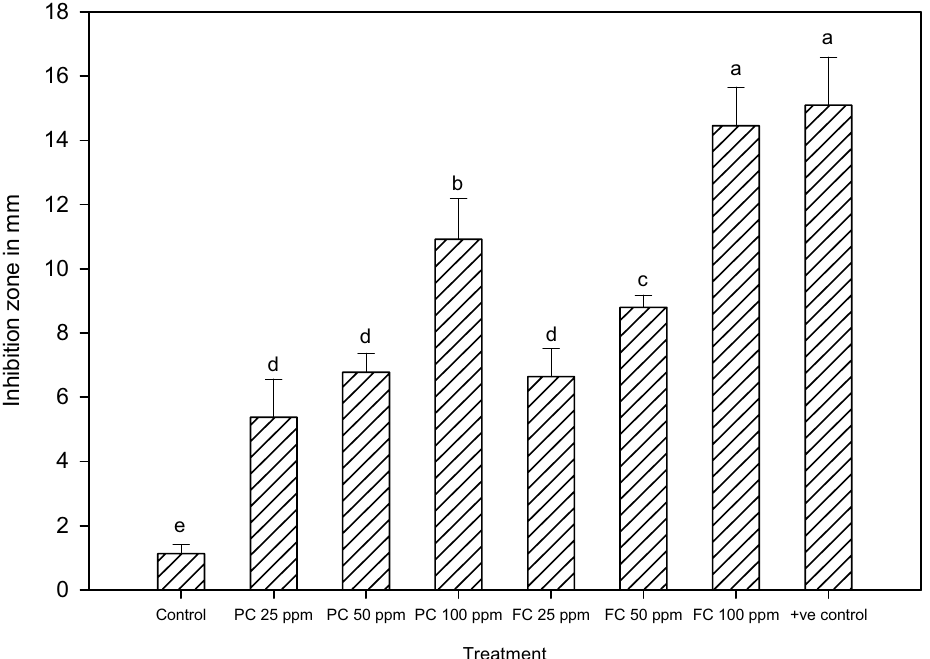
Figure 7. Antibacterial activity of fungal (FC) and product chitosan (PC) (± SEM with five replication) (with in the bars denoted by a different letter are significantly different at P ≤